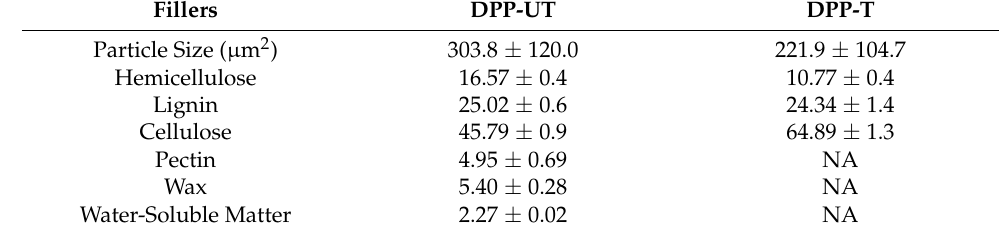
Figure 1. Particle size measurement and distribution: ( a ) DPP-UT; ( b ) DPP-T. Table 1. Chemical compositions (%) of untreated and treated date palm powders (NA: not